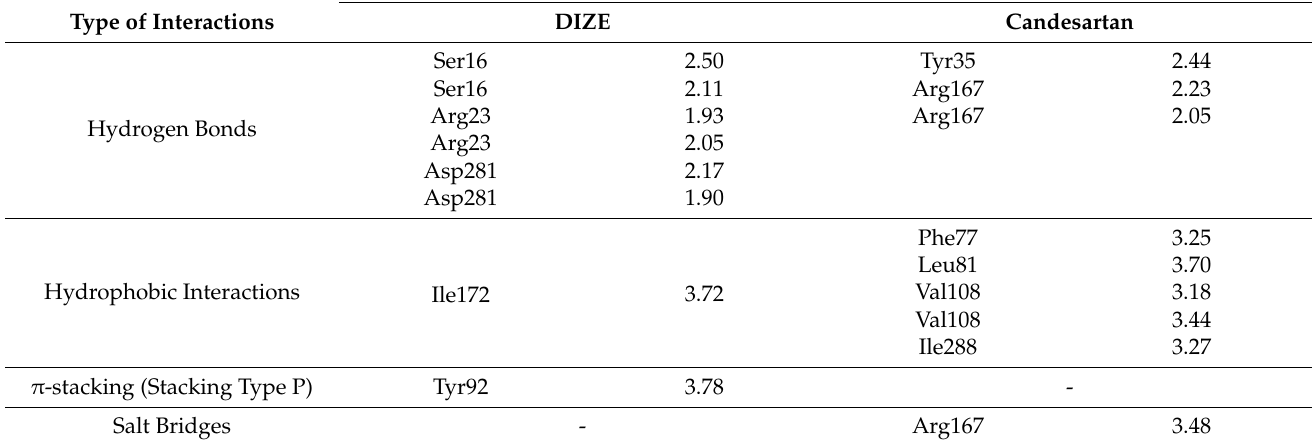
Table 5. Interactions of the amino acid residues of AT 1 R (PDB ID: 4YAY) with DIZE and candesartan using PLIP. Amino Acids of Spike Protein RBD Involved and Distance of Interactions